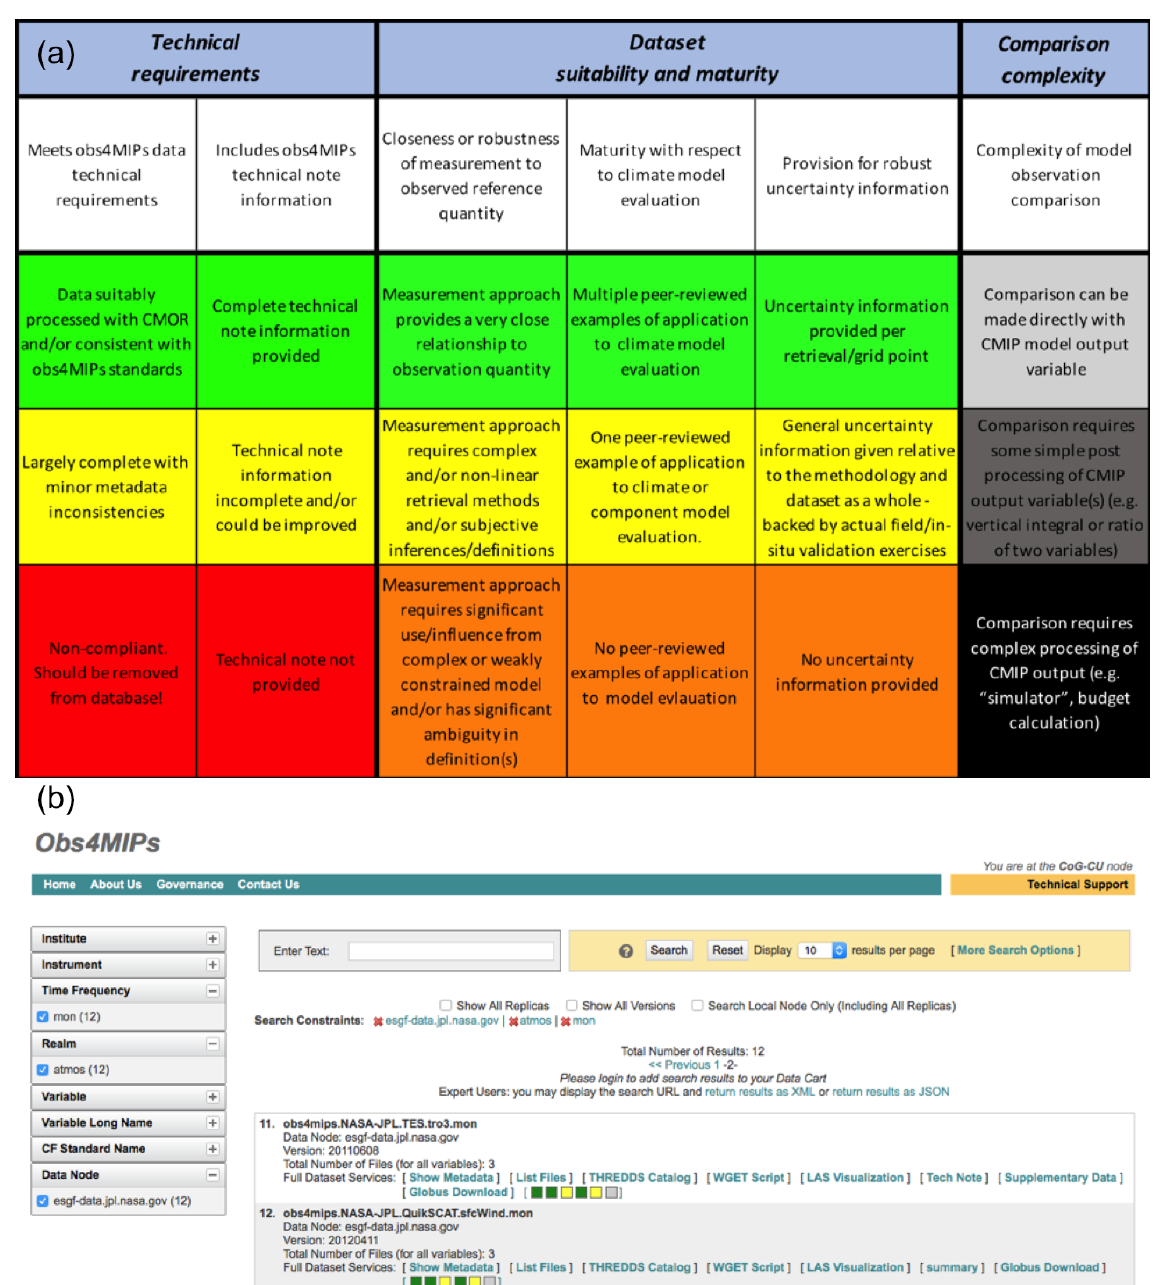
Figure 2. (a) Key to interpretation of obs4MIPs dataset indicators and (b) an example of the search result display of the indicators and links to the “[Tech Note]” and “[Supplementary Data]” in the case of datasets that include those (e.g., TES